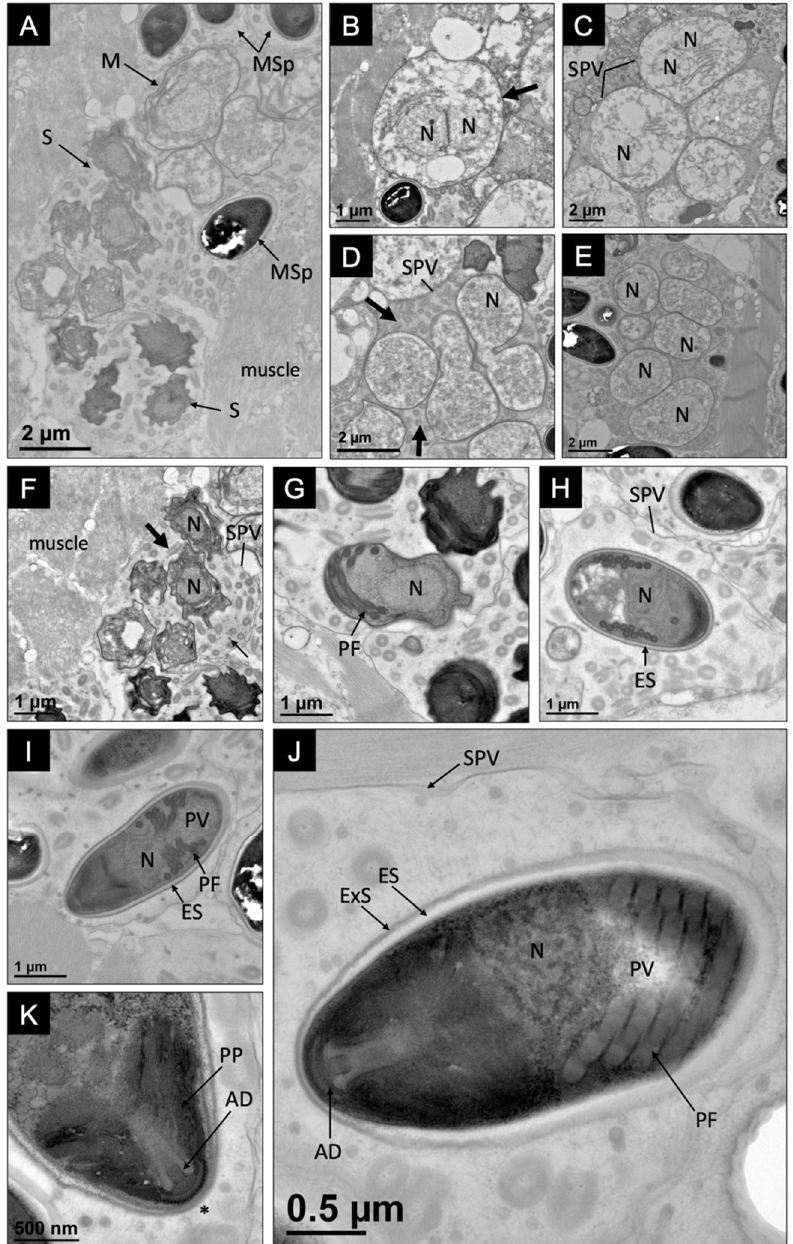
Figure 4. Intracellular developmental cycle of Astathelohania rusti n. sp. within the muscle tissue of Faxonius rusticus . ( A ) This image identifies a merogony stage (M), a sporogony (S), and mature spores (MSp) developing within their own sporophorous vesicles (SPV) in close proximity to host muscle tissue; ( B ) a binucleate meront (N = nuclei) with a thickening cell wall (arrow); ( C ) nuclei dividing within meronts and SPVs developing around each meront; ( D ) division of sporont within SPV. SPV contains tubular-like structures (arrows); ( E ) early uninucleate (N) sporoblasts maturing within SPVs; ( F ) uninucleate sporoblast developing within SPV with both microtubular-like (small arrow) and tubular-like structures (large arrow) present; ( G ) uninucleate sporoblast developing organelles including the polar filament (PF); ( H ) a near mature uninucleate spore developing within an SPV with a thickening electron-lucent endospore (ES); ( I ) a near mature uninucleate spore with a thicker endospore and well-developed polar filament (PF) and posterior vacuole (PV); ( J ) the ultrastructure of a mature uninucleate spore developing within an SPV includes a posterior vacuole (PV), polar filament (PF), anchoring disc (AD), and a spore wall with a thick electron-lucent endospore (ES) and electron-dense exospore (ExoS); ( K ) shows the fine details of the bilaminar polarplast (PP) and anchoring disc (AD) with the spore wall thinning above the anchoring disc (*).